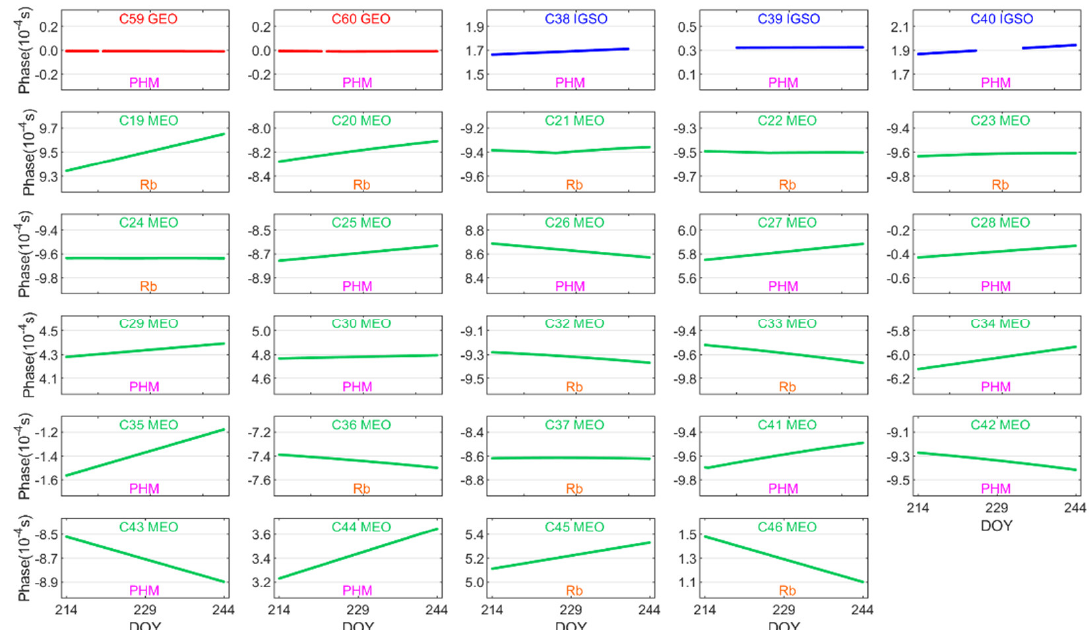
Figure 6. Phase series of BDS-3 satellites.